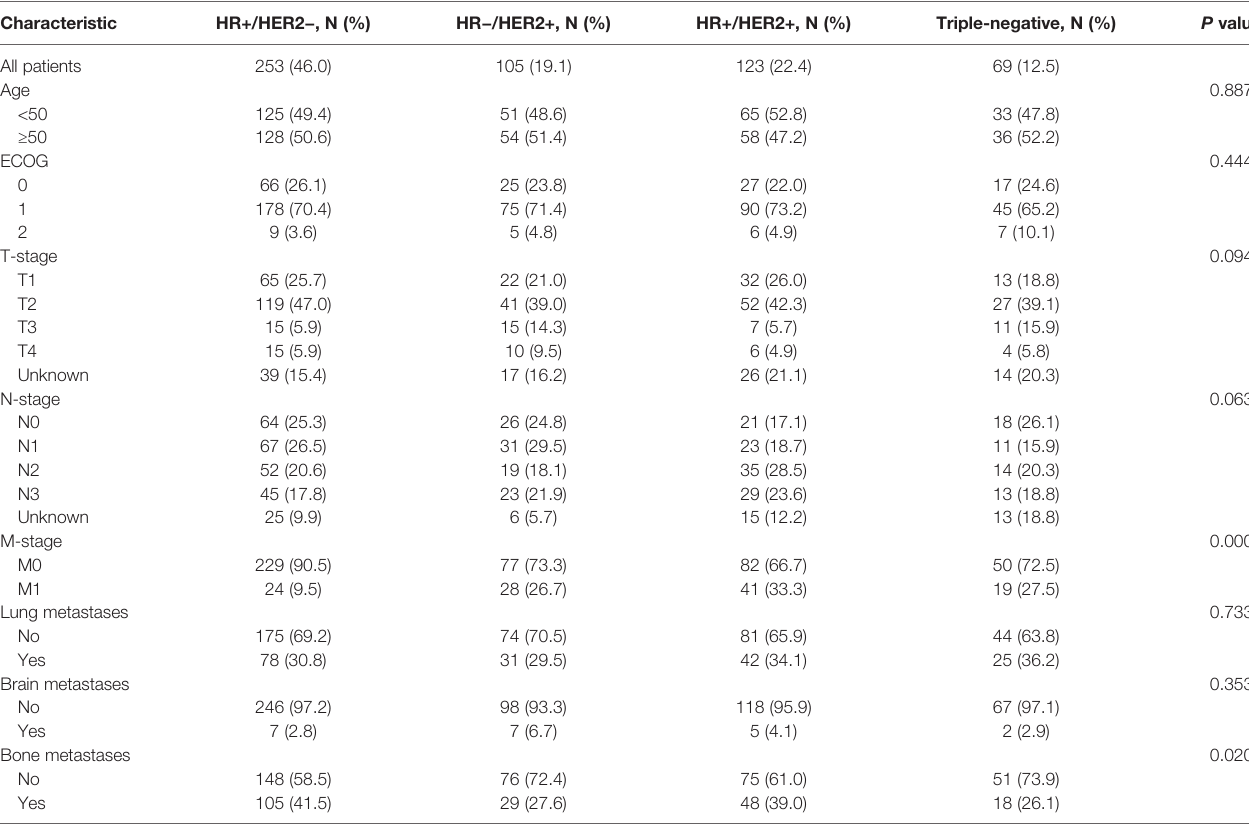
HR, hormone receptor; HER2, human epidermal growth factor receptor 2; ECOG, Eastern Cooperative Oncology Group.